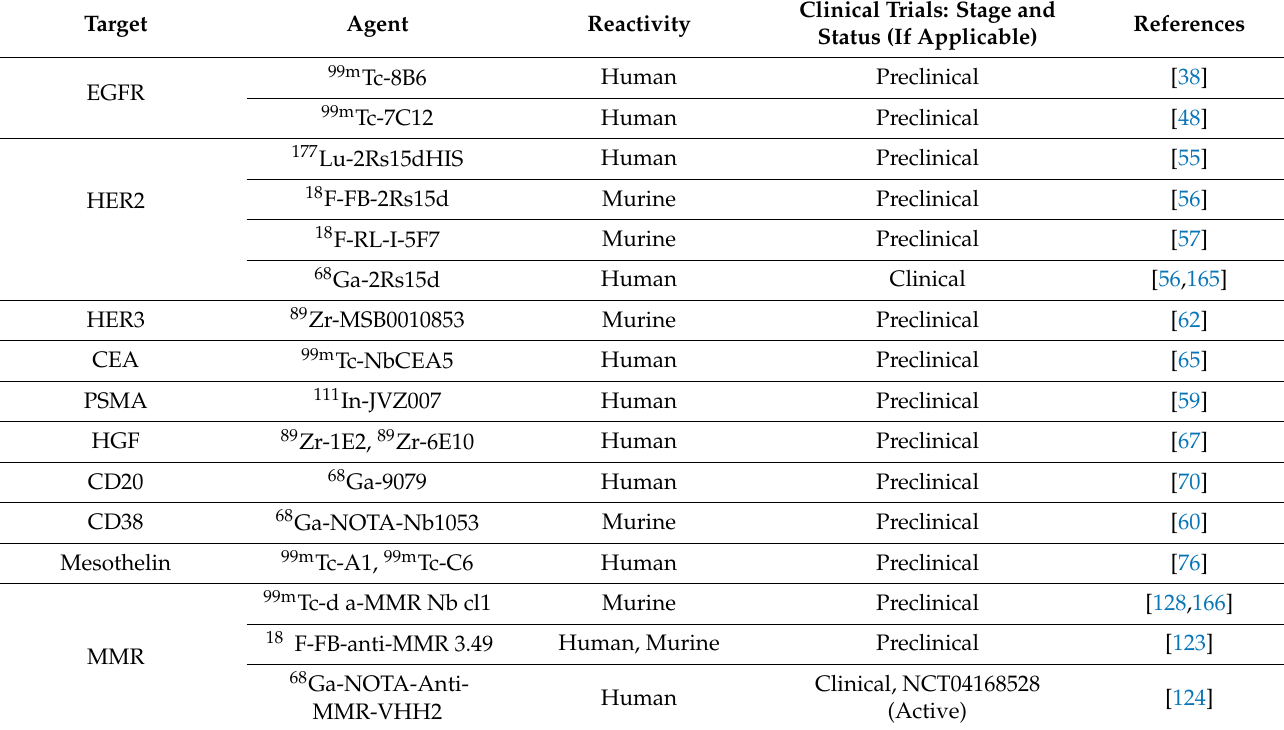
Clinical Trials: Stage